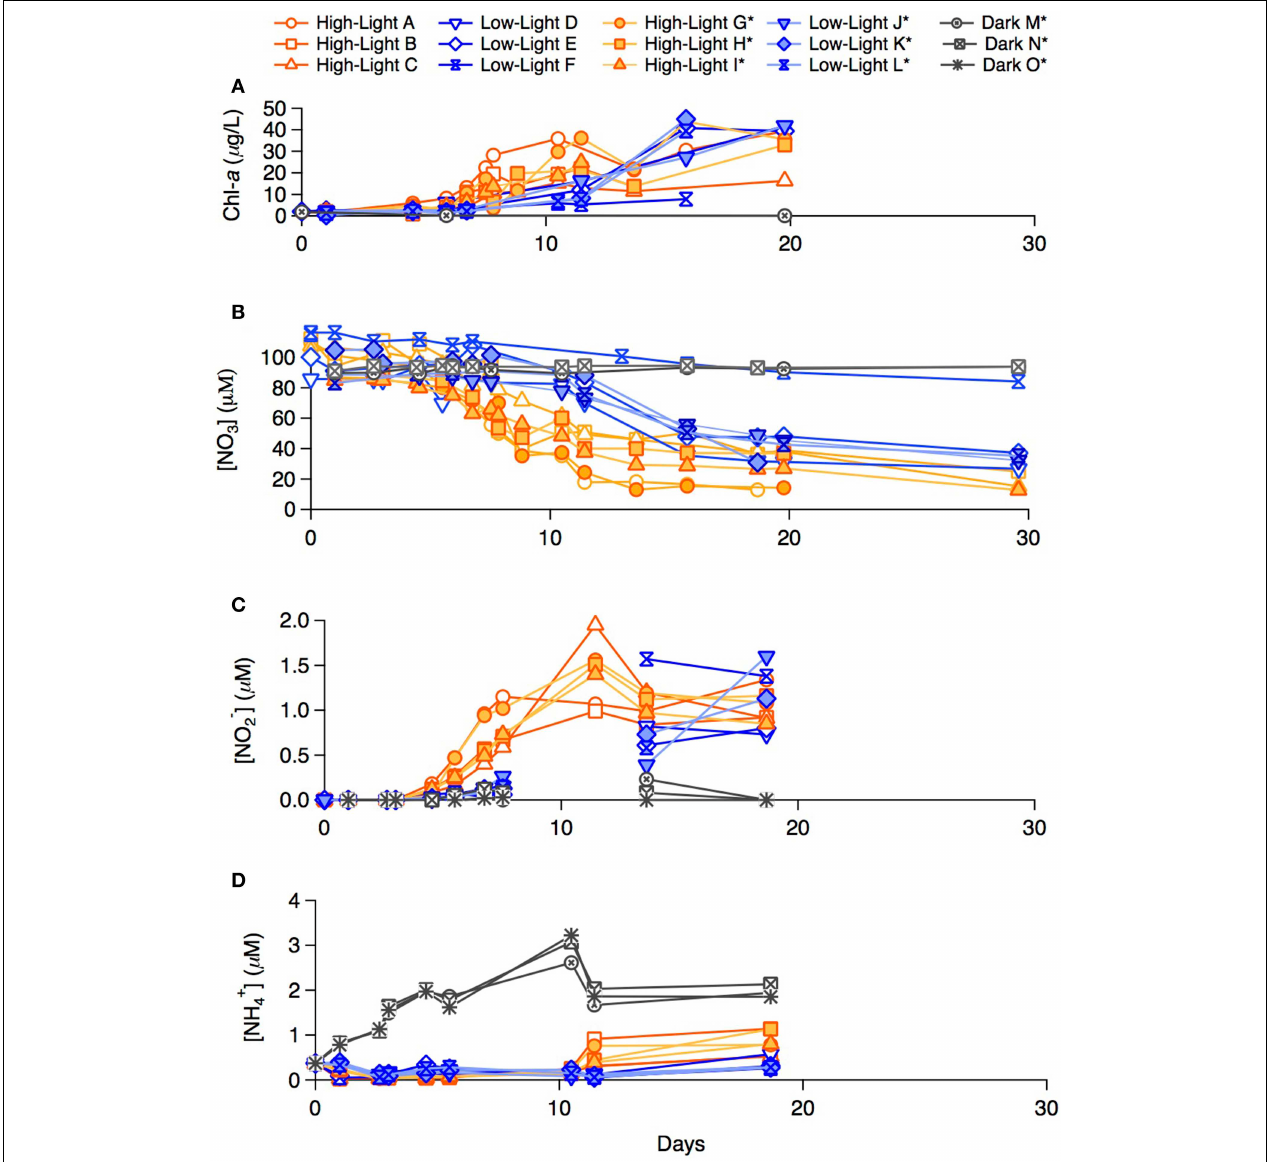
FIGURE 2 | Late summer incubation concentrations of (A) chlorophyll- a , (B) NO − 3 , (C) NO − 2 , (D) NH + 4 for both the labeled and un-labeled treatments incubated under high-light, low-light, and dark